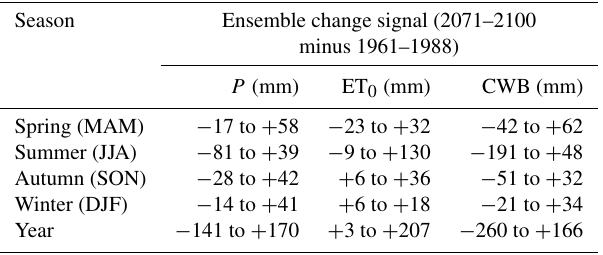
Table 3. Range of change signals of 10 climate simulations with different models for the station Geisenheim (Rheingau), Germany, for the emission scenario RCP8.5. For precipitation ( P ), reference evapotranspiration (ET 0 ), and climatic water balance (CWB, P